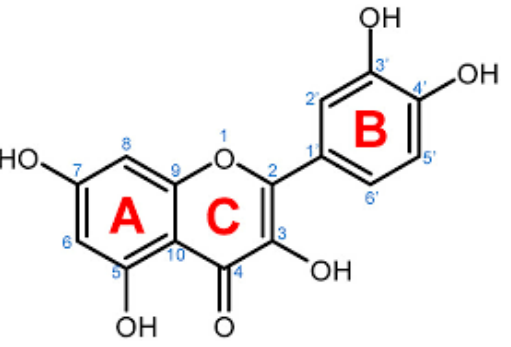
Figure 1. Chemical illustration of Quercetin taken from pubChem.